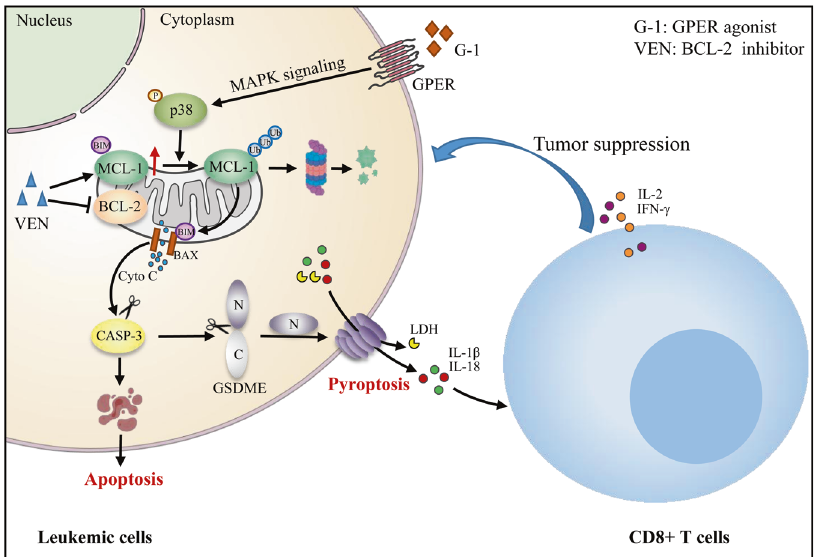
Fig. 8 Proposed model for how targeted activation of GPER improves the antileukemic activity of venetoclax. G-1 and VEN synergistically trigger simultaneous apoptosis and GSDME-dependent pyroptosis via activating the p38-MAPK/MCL-1 axis in leukemic cells. Moreover, the release of IL-1 β /18 induced by pyroptosis heightens the tumor suppressive function of CD8 + T